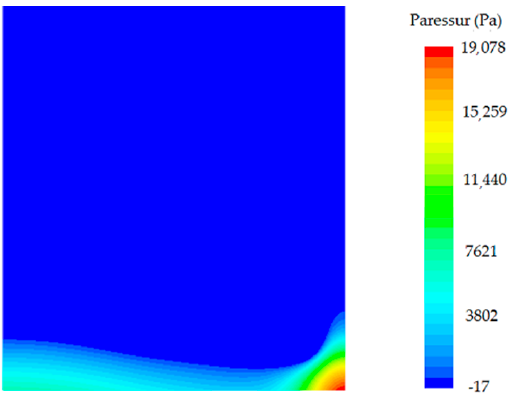
( ∆ x = 0.0125 m, t = 0.9 s ) .